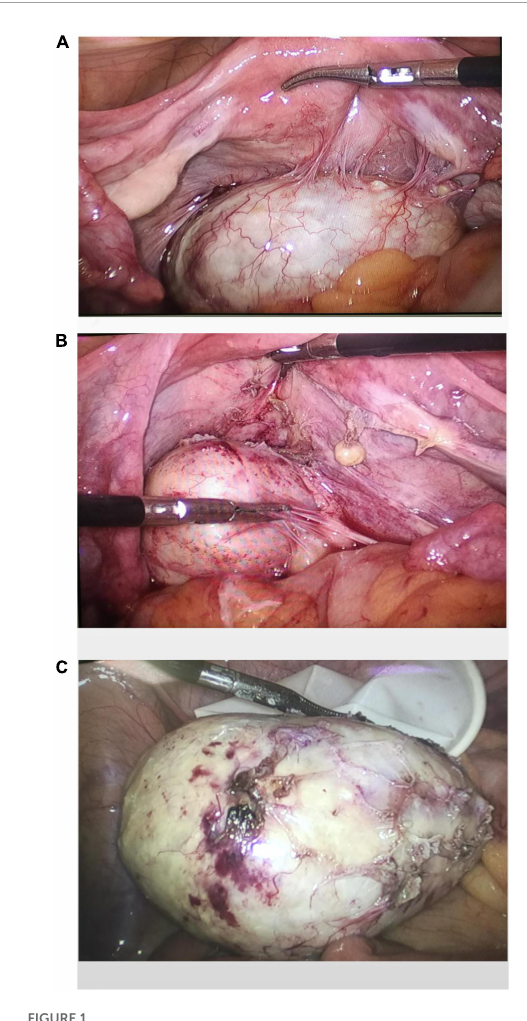
FIGURE1 Intraoperative exploration revealed a teratoma in the utero-rectal fossa, adherent to the posterior uterine wall, right adnexa, and mesentery (A) . The teratoma was disconnected from the posterior uterine wall, right adnexa, and mesentery (B) . Gross observation of the specimen (C) .